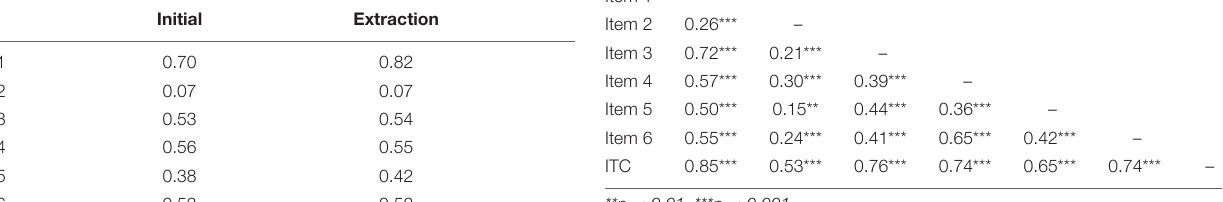
TABLE 2 | Communalities for the exploratory factor analysis of the F-BISS.